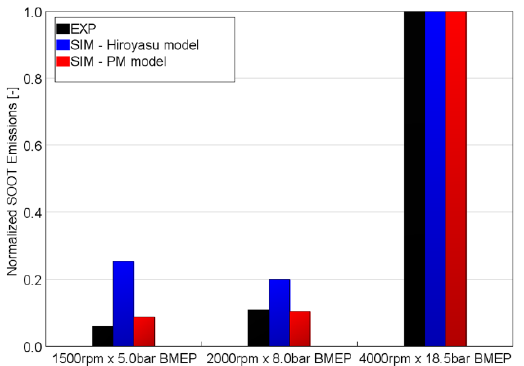
Figure 12. NOx emissions normalized respect to the corresponding value for the 4000 rpm × 18.5 bar BMEP WP, experimental data (black) and simulated (red).